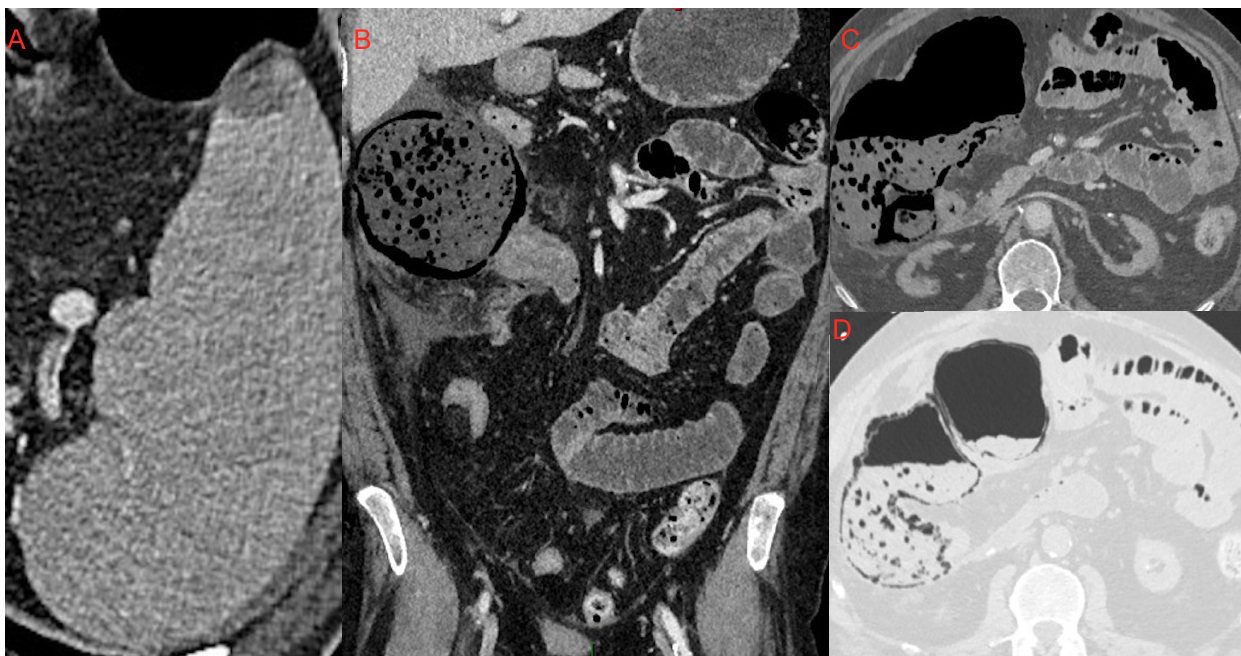
Figure 12. Small area of splenic infarction ( A ); infarction of the cecum and right colon ( B – D ): It is possible to notice the marked dilatation of the ascending colon, with parietal pneumatosis and hydro-aerial levels. It was associated with abdominal effusion in right subhepatic space and paracolic gutter which extended to the pelvic cavity.